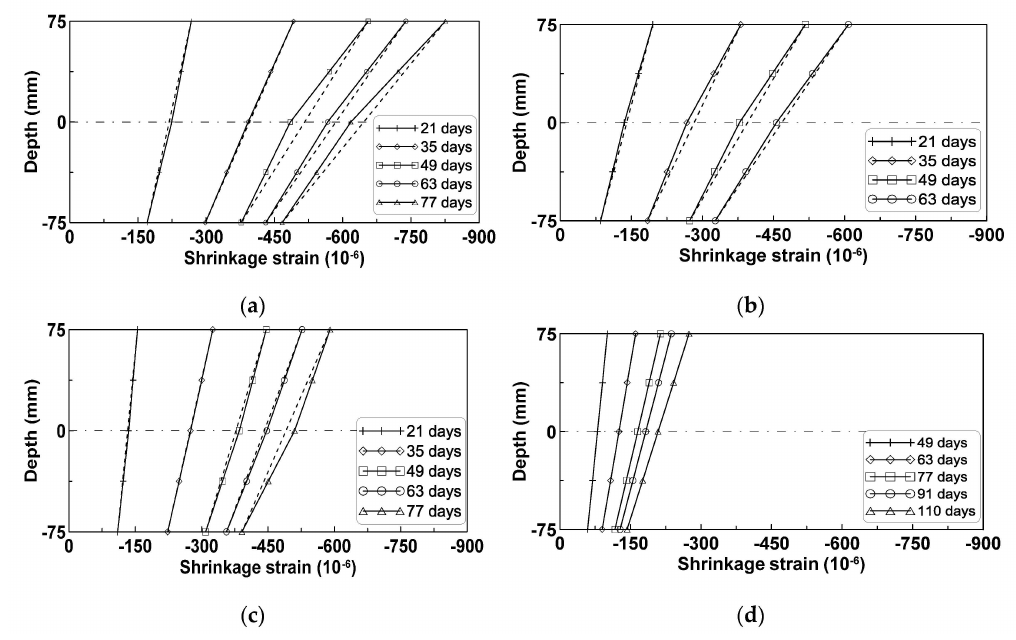
Figure 5. Variation of shrinkage strain distributions within beam depth: ( a ) Test series A; ( b ) test series B; ( c ) test series C; ( d ) test series D.